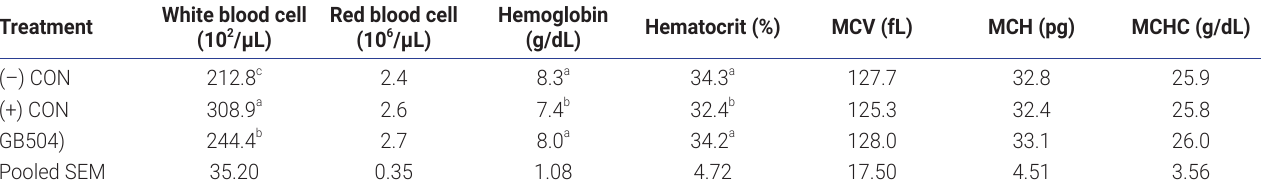
Table 8. Effects of overcrowding and diurnal temperature range stress on blood cell count (Trial 4) White blood cell Treatment (10 2